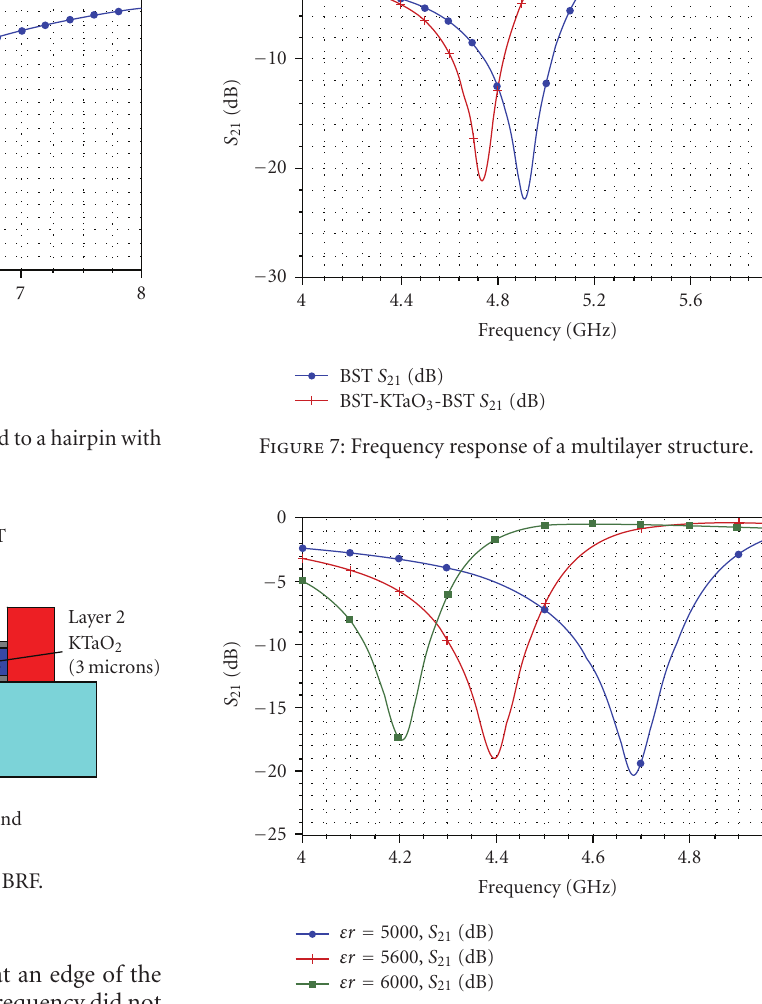
layer. The figure indicates an improvement in Q of up to 20%. The resonant frequency shifted downward as